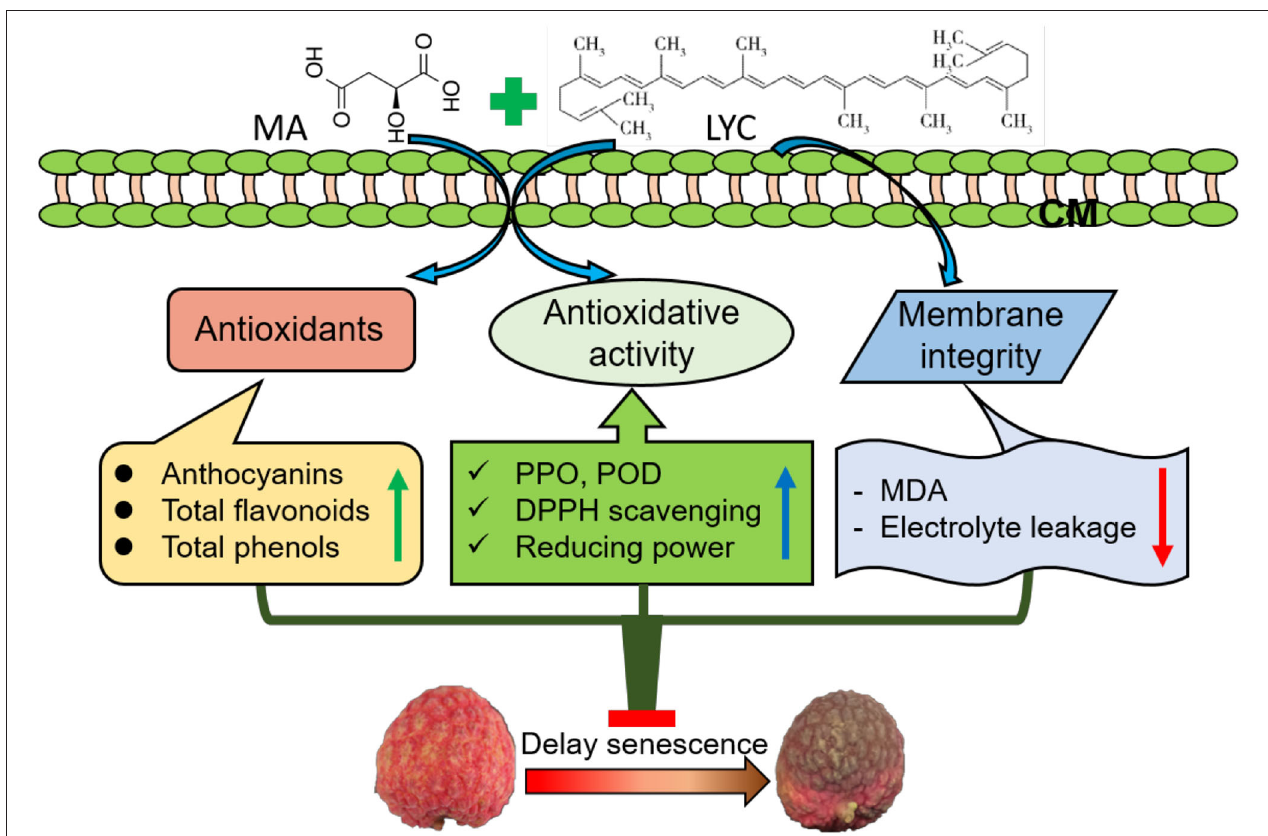
FIGURE 7 | The potential preliminary mechanism for the regulation of combined treatment of MA an LYC on the pericarp browning in litchi fruit by maintaining the antioxidants level and antioxidant activity and the membrane integrity during storage.